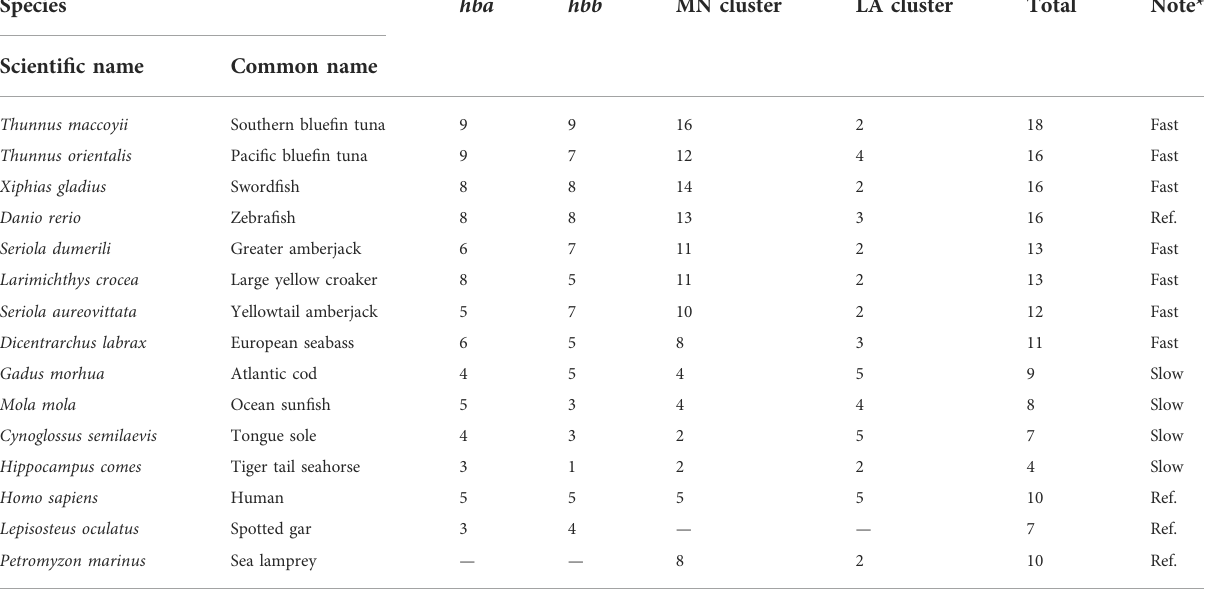
TABLE 2 Copy numbers of hemoglobin ( hb ) genes in the examined genomes.